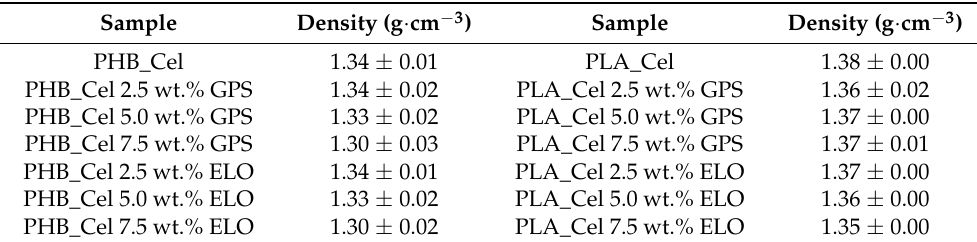
Table 1. Density of the PHB- and PLA-based composites reinforced with cellulose micronized fibers without additives and with different percentages of GPS and ELO